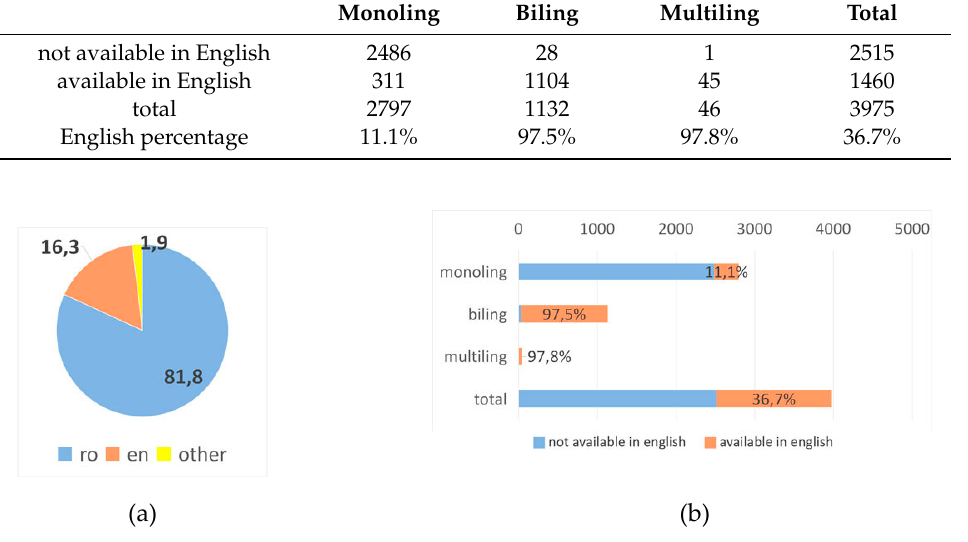
Figure A23. Visualization of the results for domain ro. ( a ) Primary languages pie chart and ( b ) English language availability bar chart.